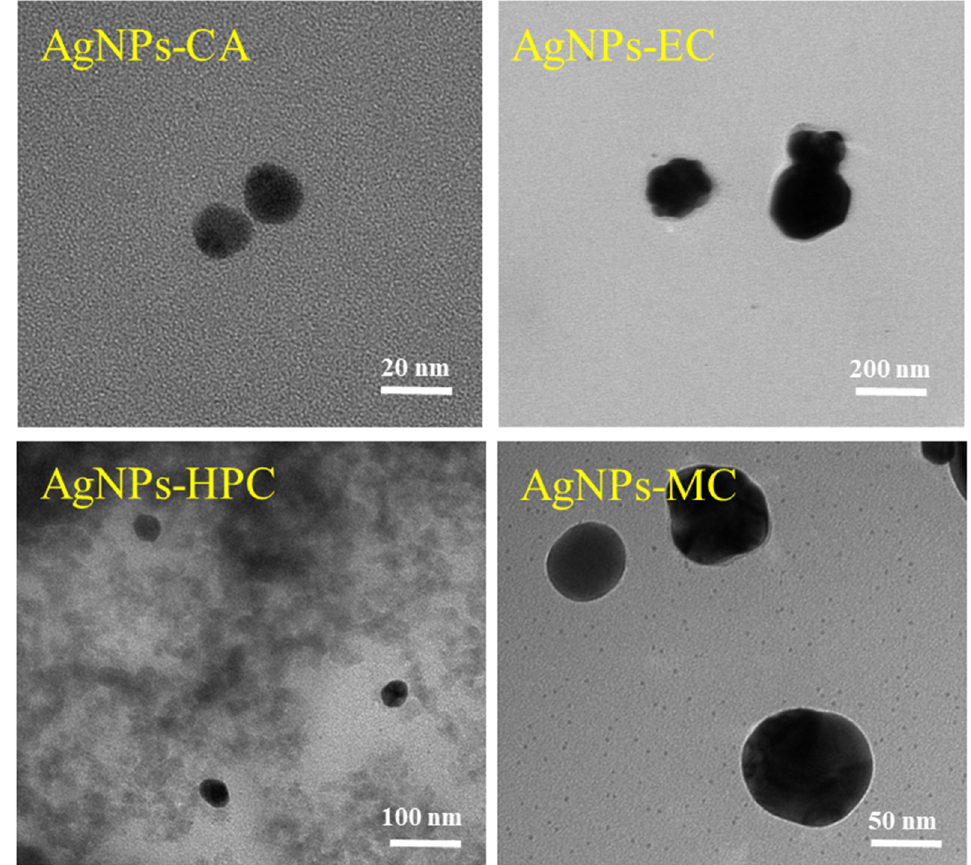
Molecules 2022 , 27 , 6680 Figure 5. TEM micrographs of AgNPs prepared using different cellulose derivatives. Table 2. Particle size and spectral features of AgNPs determined using TEM.